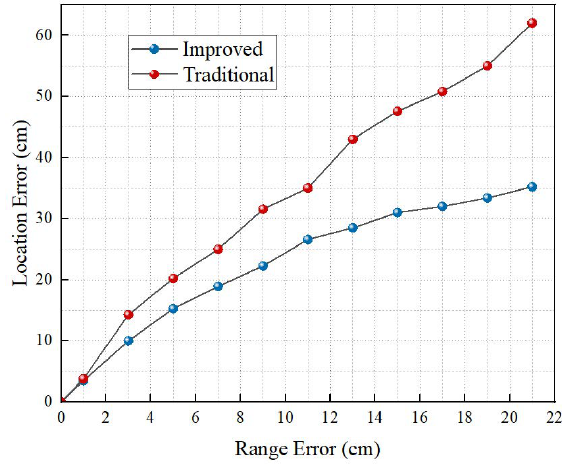
Figure 9. Impact of the range error on the localization performance.